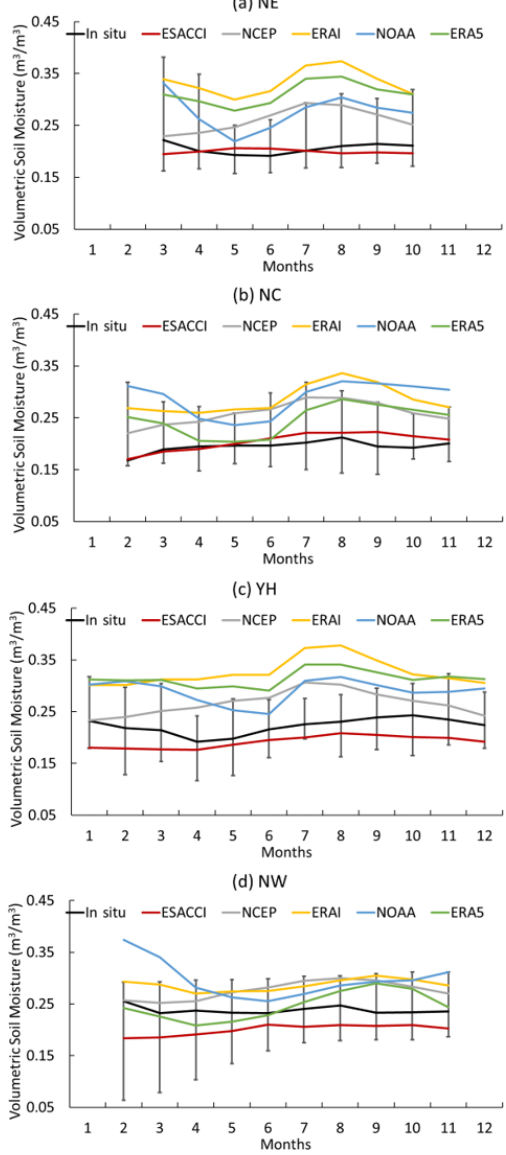
Figure 6. Seasonality of SM distributions based on in situ observa- tions and five products averaged over the (a) NE, (b) NC, (c) YH, and (d) NW regions from 1981 to